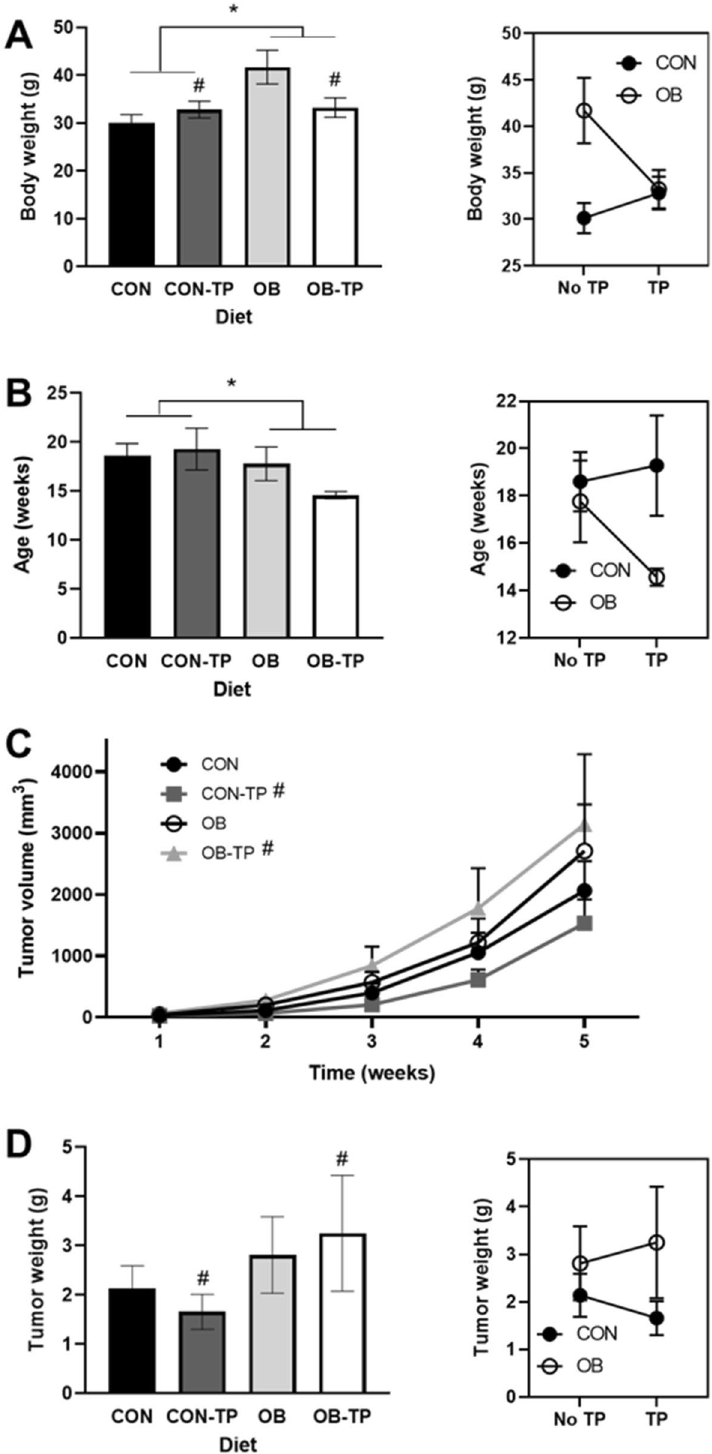
Figure 2. ( A ) Body weight and ( B ) age at tumor detection with corresponding interaction plots. A reversal of effect indicates that tomato powder (TP) led to divergent effects depending on incorporation with control (CON) or obesogenic (OB) diets. ( C ) Tumor volume (mm3) over time. Tumor growth rate was not significantly different between dietary groups after adjusting for body weight at tumor detection, but tumor volume at each time point was significantly affected by TP depending on diet. D) Tumor weight at euthanasia was differentially affected by TP depending on incorporation with CON or OB diets. *Indicates statistical significance ( p < 0.05) and # indicates a significant interaction effect ( p < 0.15; by mixed-model ANCOVA with body weight at tumor detection as a covariate, n = 5/dietary